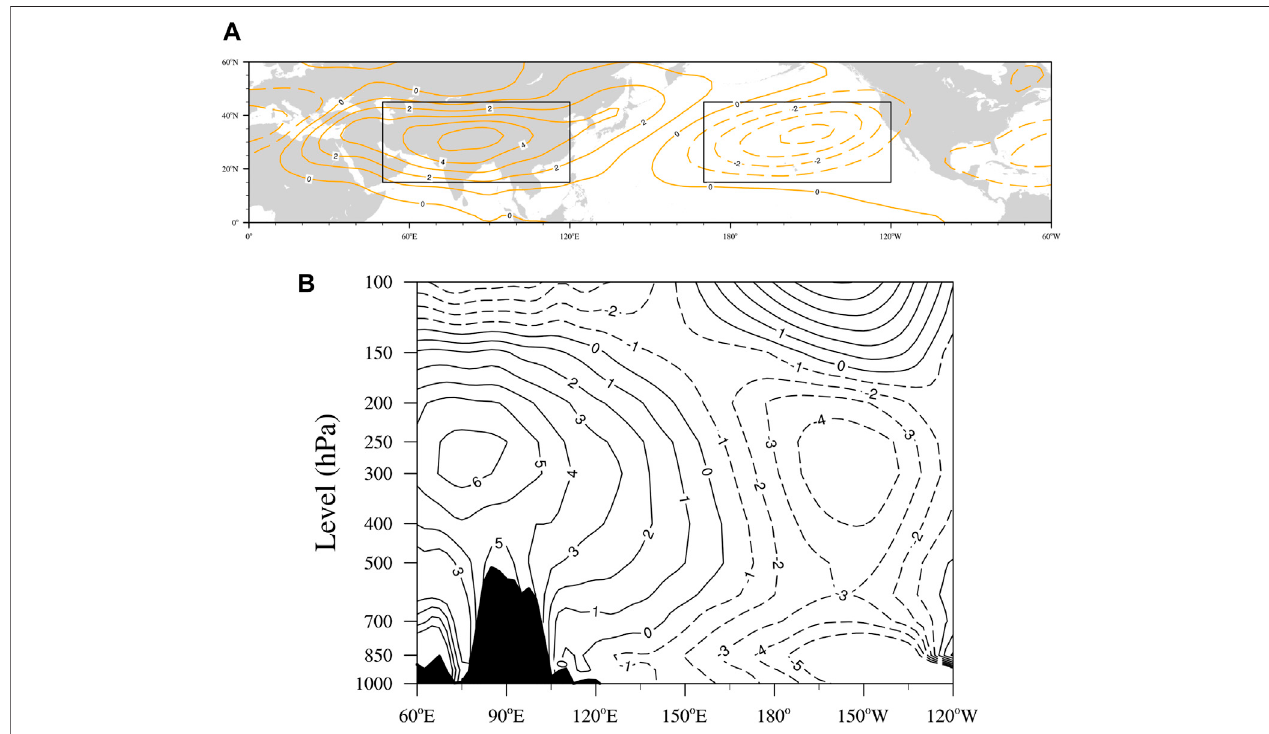
FIGURE 1 | (A) Climatology ( ° C) of the August mean T ’ over the Asian – Paci fi c region and (B) longitude – pressure section of August T ’ ( ° C) along 30 ° N during 1961 – 2020 (the black area represents the mountains).